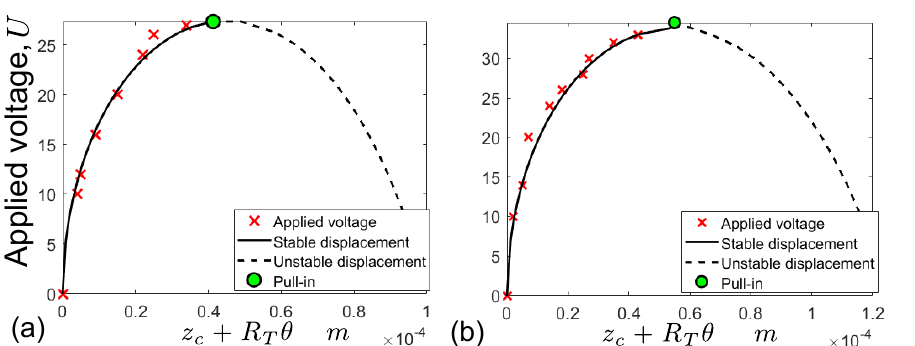
Figure 6. Measured data and results of model=ling in absolute values: ( a ) for measurement I; ( b ) for measurement II (other details are shown in Table